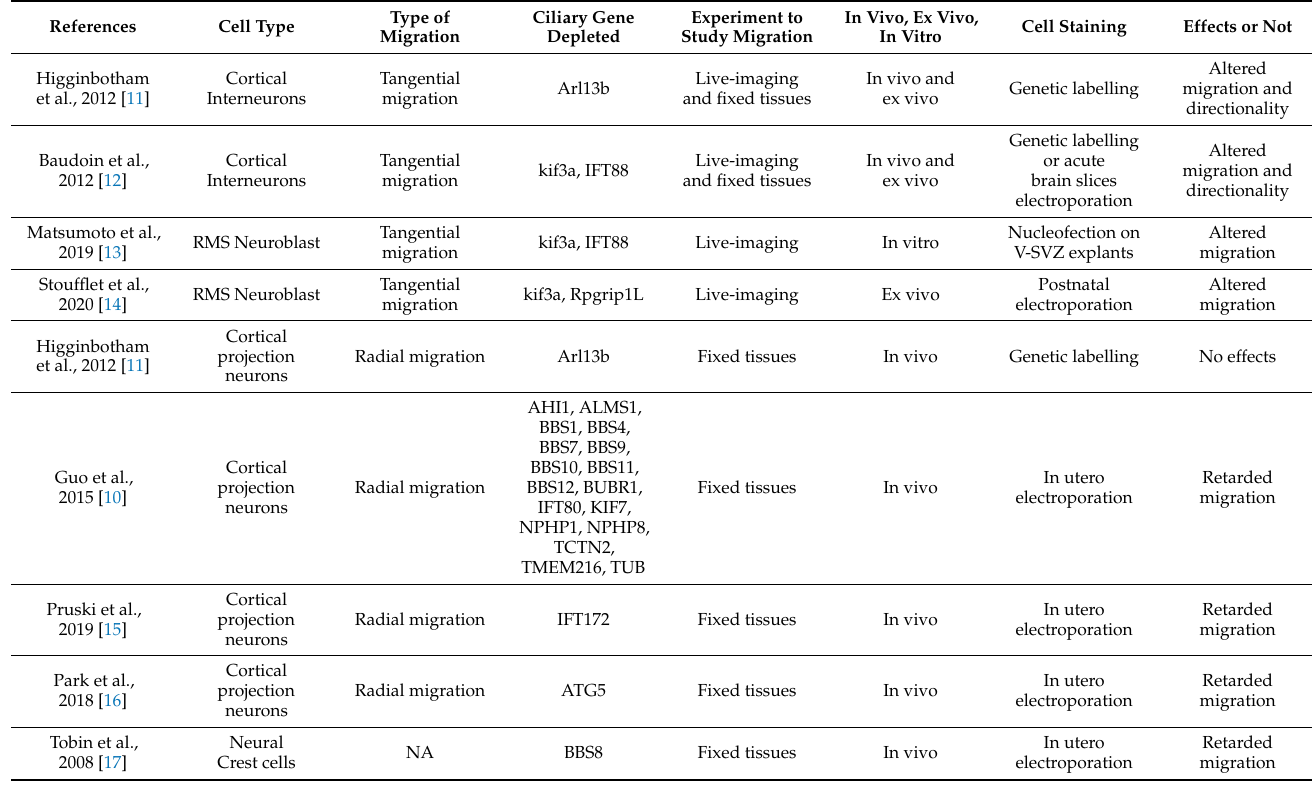
Table 1. Summary of the effects of ciliary mutations on neuronal